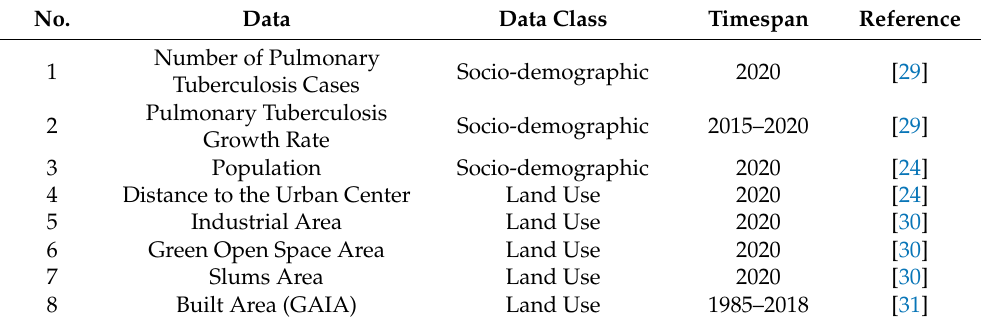
Table 1. Characteristics of the spatial data used in this study.